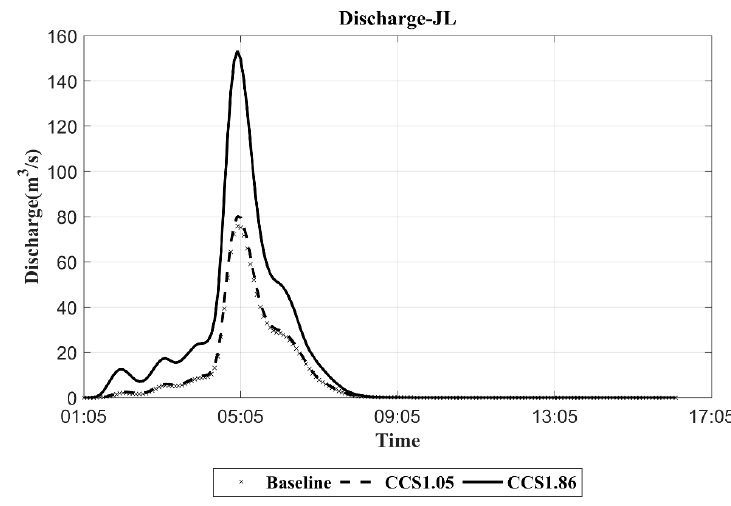
Figure 6. Time series plot of discharge at the junction point (JP) from the hydrological modeling.